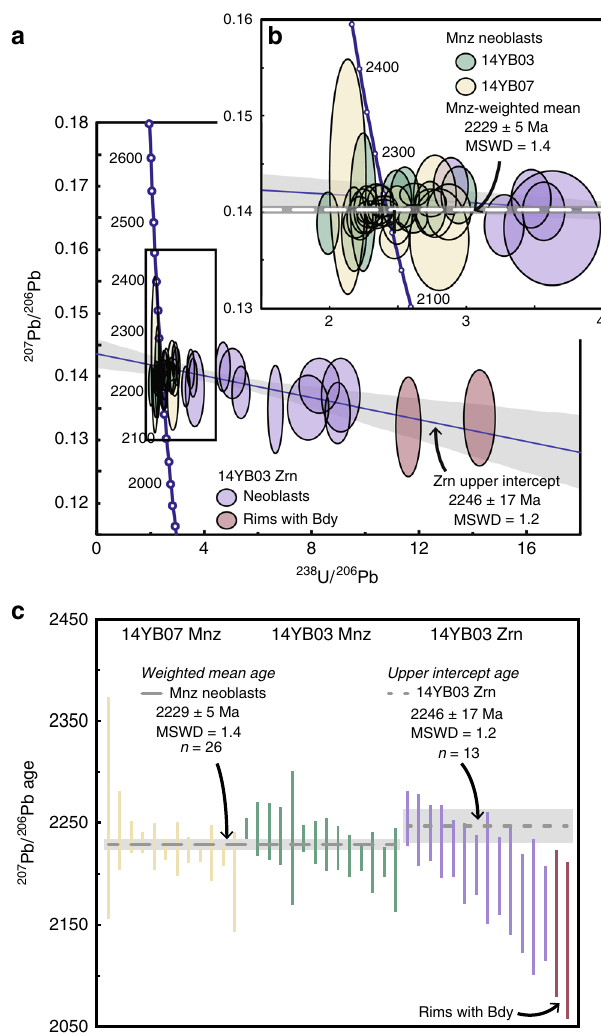
Fig. 3 Shock-recrystallised zircon and monazite age spectra. a Zircon (Zrn) and monazite (Mnz) U – Pb Tera-Wasserburg concordia plot of shock- recrystallised zircon and monazite neoblasts from the Barlangi granophyre